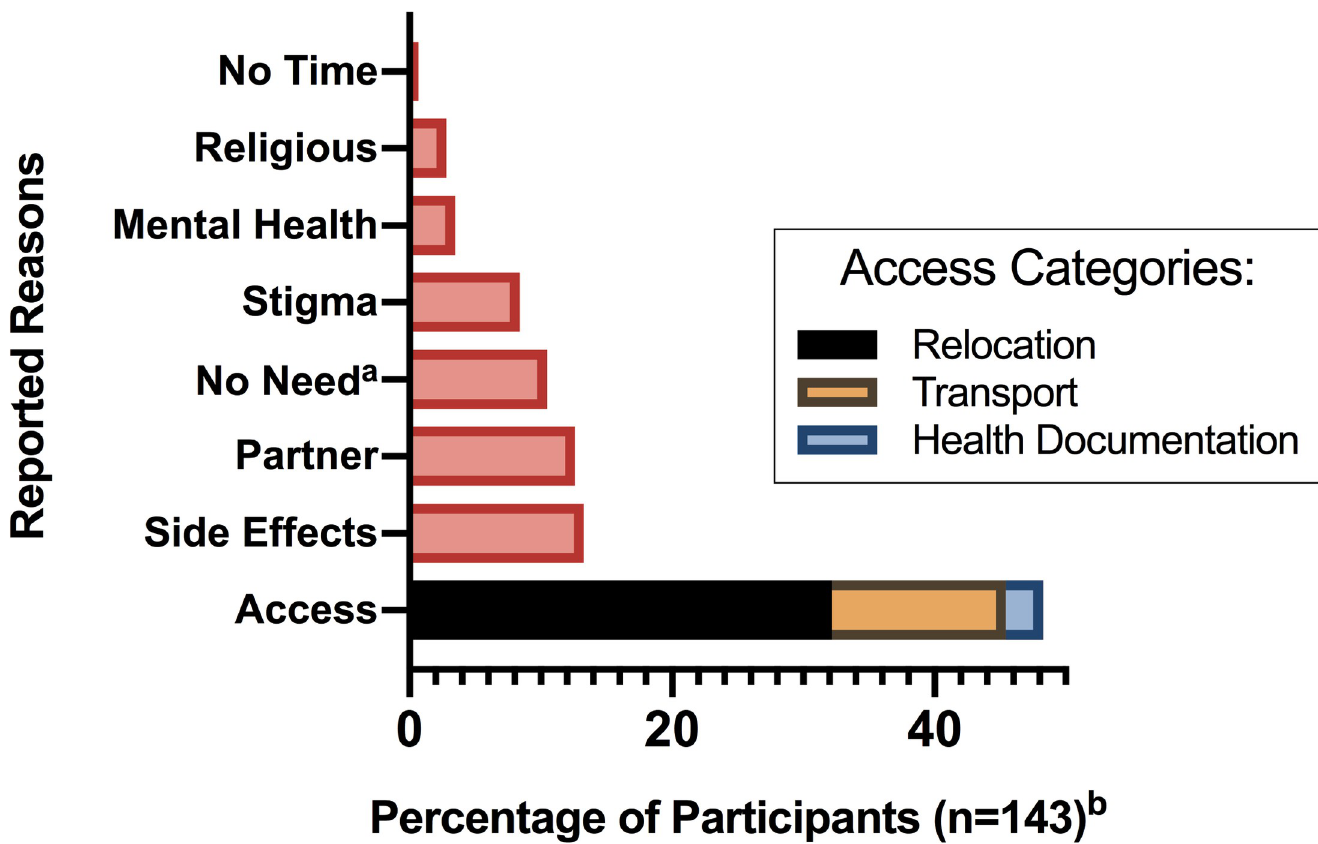
Fig 1. Free response reasons reported by participants for art interruption. a Participants expressed that they stopped taking ART because they felt healthy. b The free response reason for ART interruption was missing in 7 reinitiating participants.